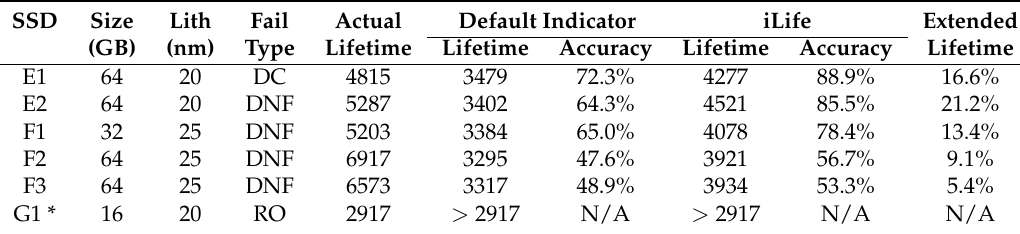
Table 9. Evaluation of iLife. The lifetime is measured in workload iteration count. All percentages are of the actual lifetime (i.e., the actual lifetime is 100%). The last column shows the additional reliable usage time by using iLife, compared with using the default indicator. * Due to the Read Only (RO) protection in G1, both the default indicator and iLife did not report failure before RO.